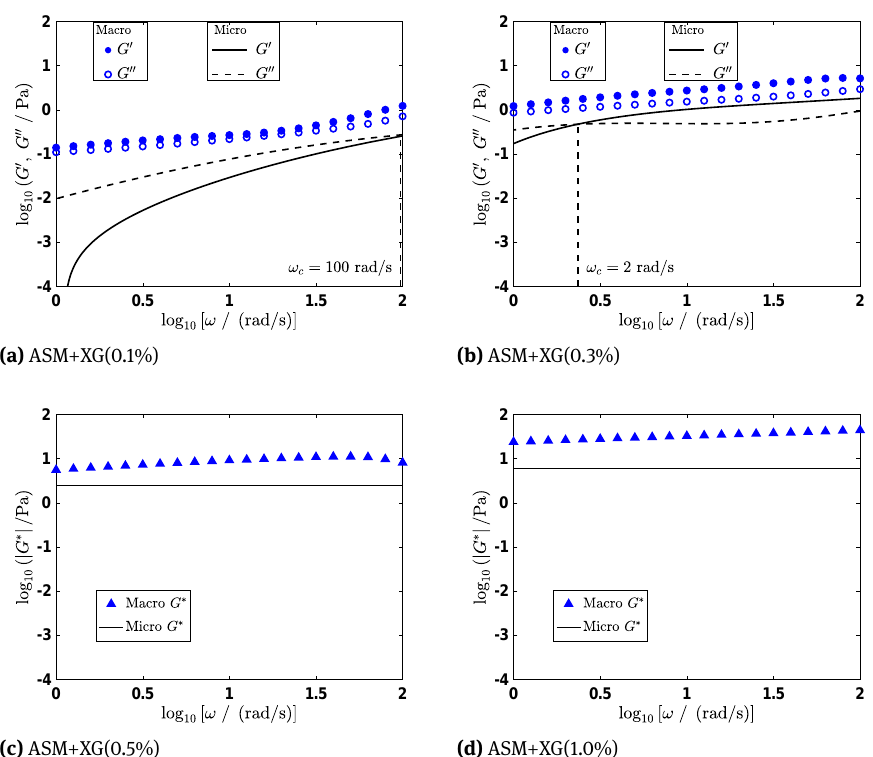
Figure 9: Comparison between microscopic rheology and macroscopic rheology for varying concentrations of XG. (a), (b) Elastic modulus G ′ and viscous modulus G ′′ for concentrations of XG of 0.1% and 0.3%. Lines are used for microscopic rheology, and spheres are used for macroscopic rheology. Solid lines or filled symbols are used for G ′ and dashed lines or open symbols are used for G ′′ . (c), (d) Comparison of ⃒ ⃒ G * ⃒ ⃒ of concentrations of XG of 0.5% and 1.0%. Lines are used for microscopic rheology and triangular symbols are used for macroscopic rheology.